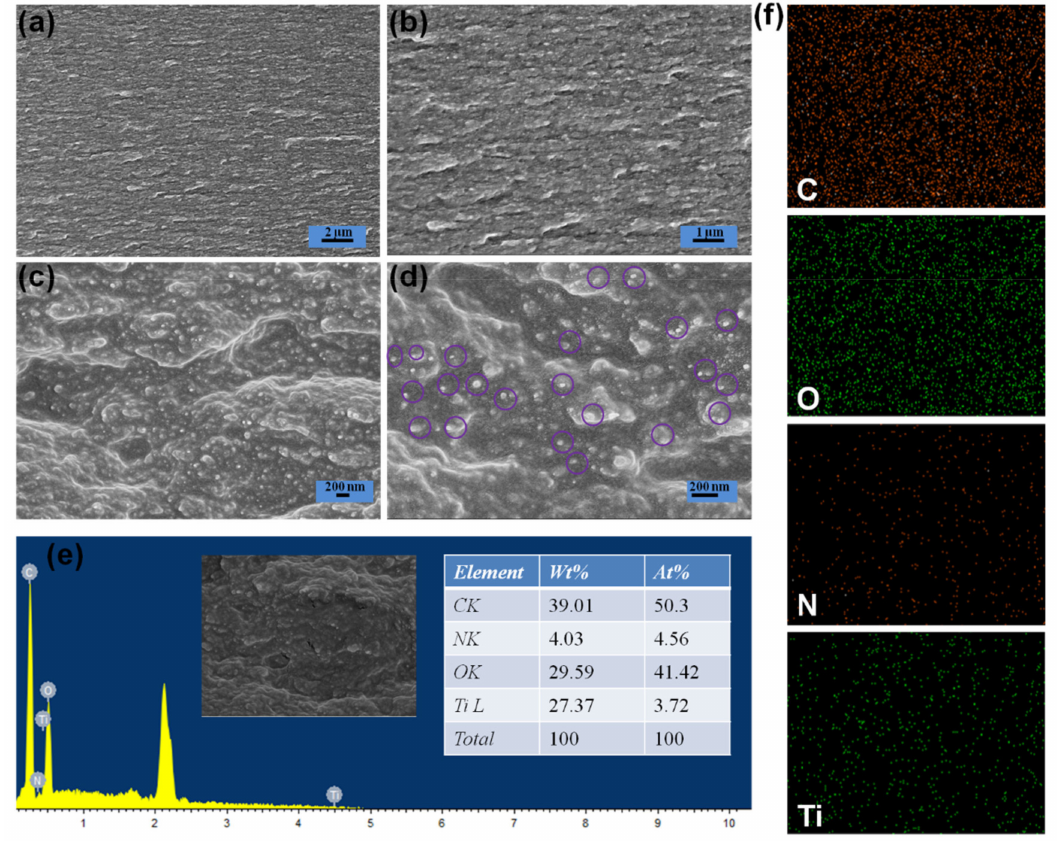
Figure 3. ( a – d ) Cross-sectional SEM images of MNP@CBP5; ( e ) EDS spectrum of MNP@CBP5; ( f ) elemental mapping images of MNP@CBP5 for carbon, oxygen, nitrogen and titanium. × 5000 magnification ( a ), × 10,000 magnification ( b ), × 50,000 magnification ( c ), × 100,000